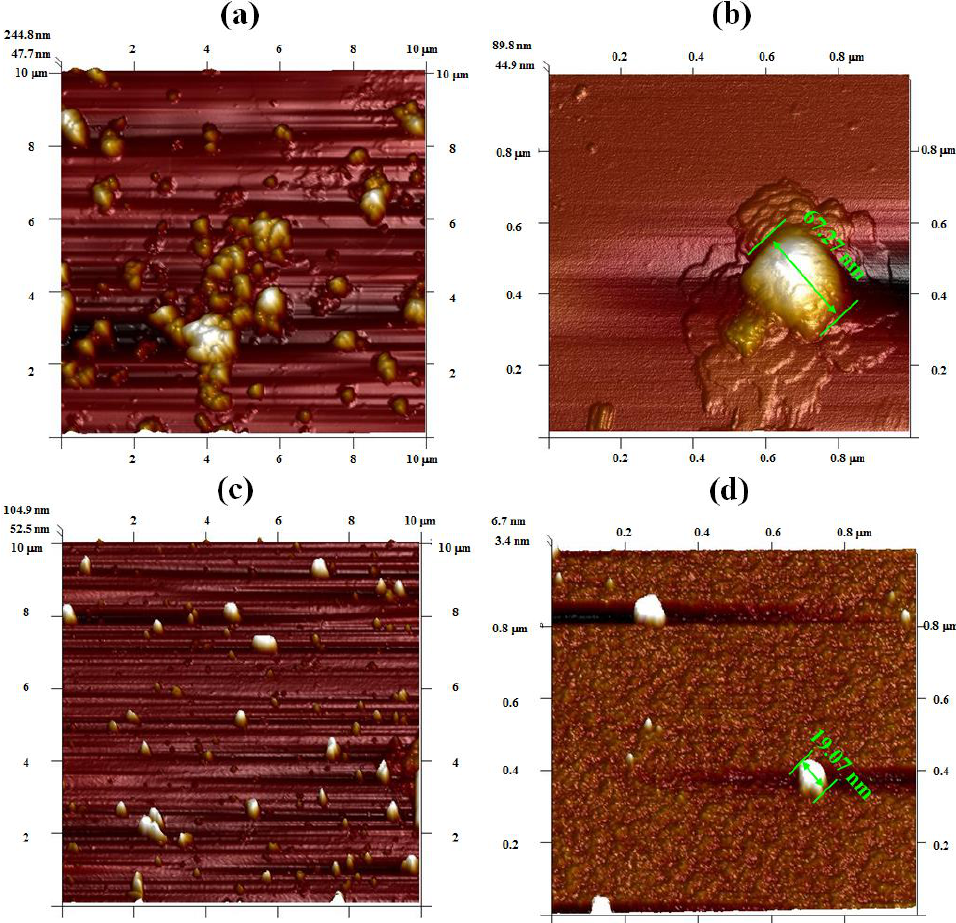
Figure 2. AFM images of nano-ZnO. ( a , c ) Surface topography of nano-ZnO by mechanical stirring method and ultrasonic method, respectively; ( b , d ) size of nano-ZnO by mechanical stirring method and ultrasonic method, respectively.